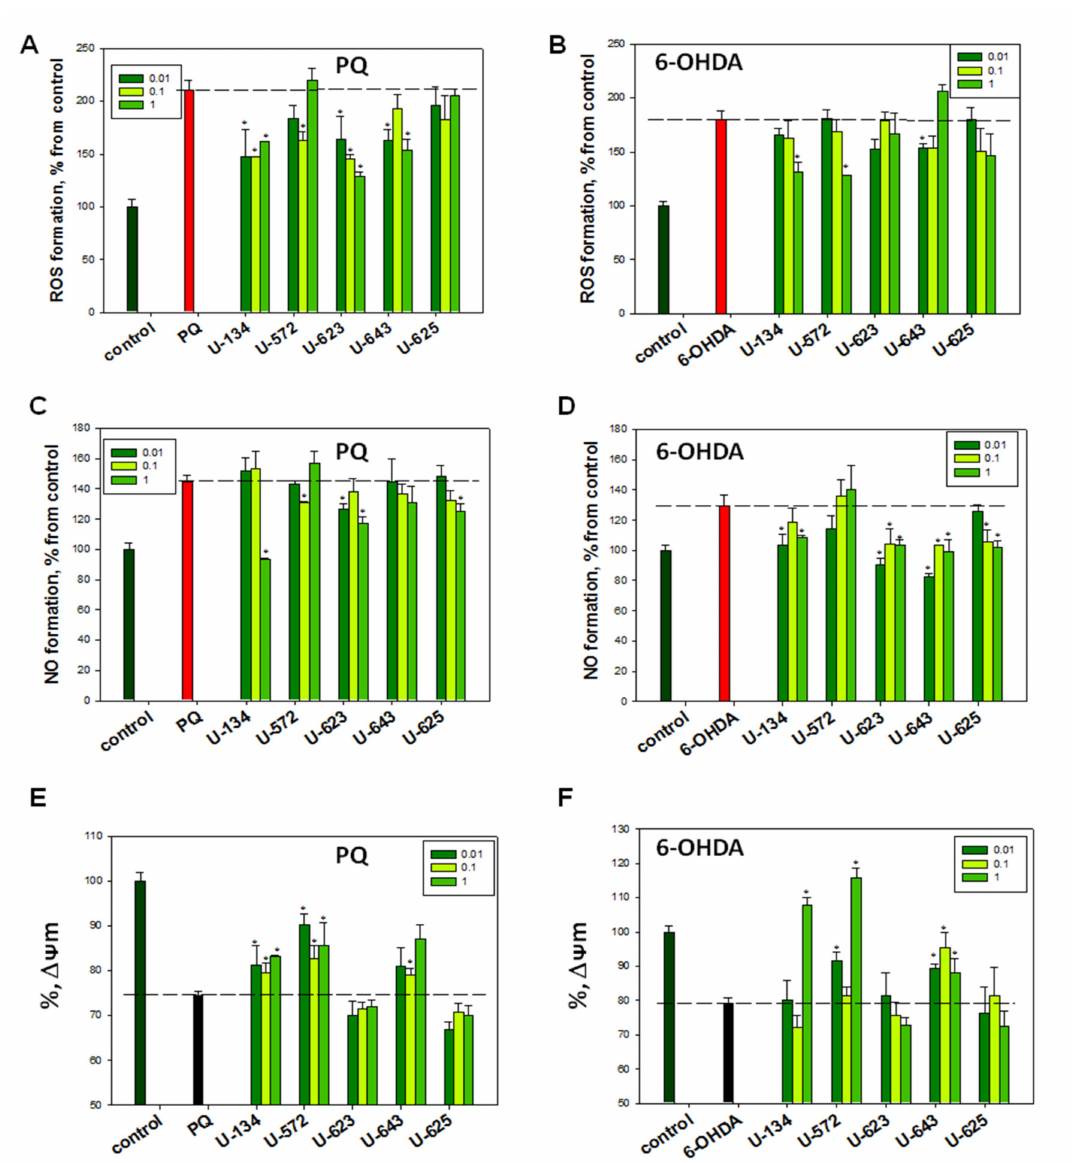
Figure 4. The effects of 1,4-NQs on the levels of ROS and NO production and MMP levels in Neuro-2a cells. Cells (1 × 10 4 cells/well) were incubated with PQ at 1.0 mM for 3 h ( A , C ); or for 1 h ( E ); or 6-OHDA, 25.0 µ M for 3 h ( B , D ); or 90.0 µ M for 5 h ( F ). ROS, intracellular NO levels and MMP levels were measured with H 2 DCF-DA, DAF-FM and TMRM fluorescent probes using spectrofluorimetry. Data are presented as m ± se ( n = 3). * p < 0.05 compared to cells exposed to PQ or 6-OHDA